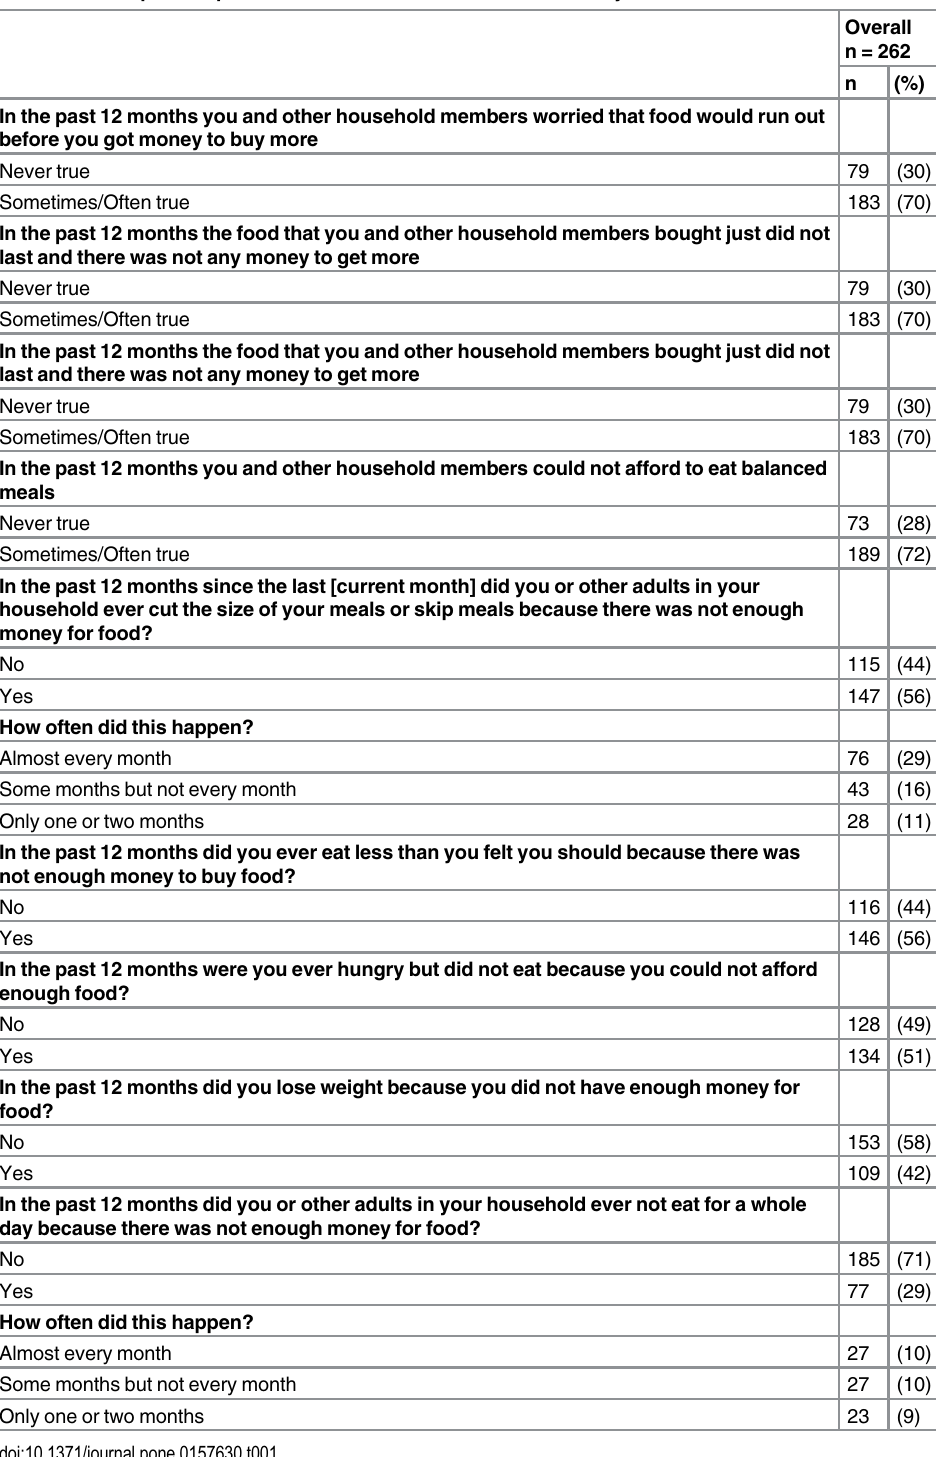
Table 1. Participant responses to Canada Household Food Security Scale